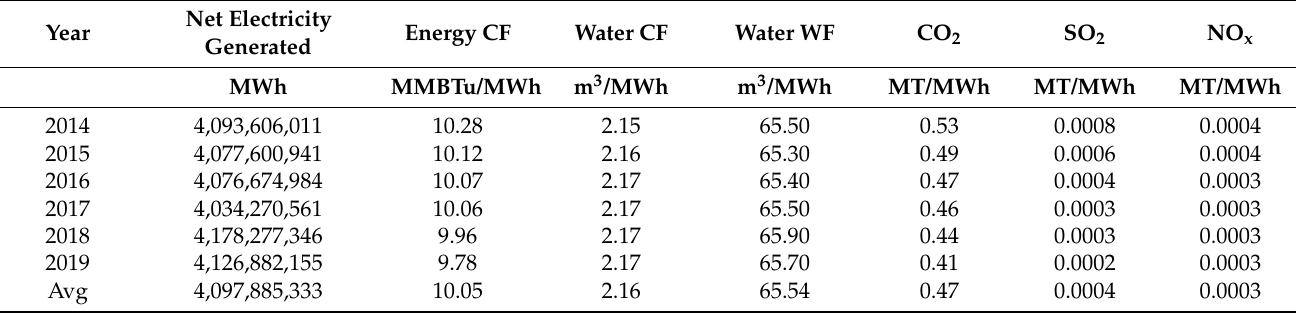
Table 3. Annual rates of energy consumption (MMBTu), water consumption and water withdrawn (m 3 ), and air emissions (metric ton, MT) per MWh of net electricity generated in the US 2014–2019 averaged across all energy sources; where Avg is the annual average 2014–2019, CF is consumption footprint, and WF is withdrawal